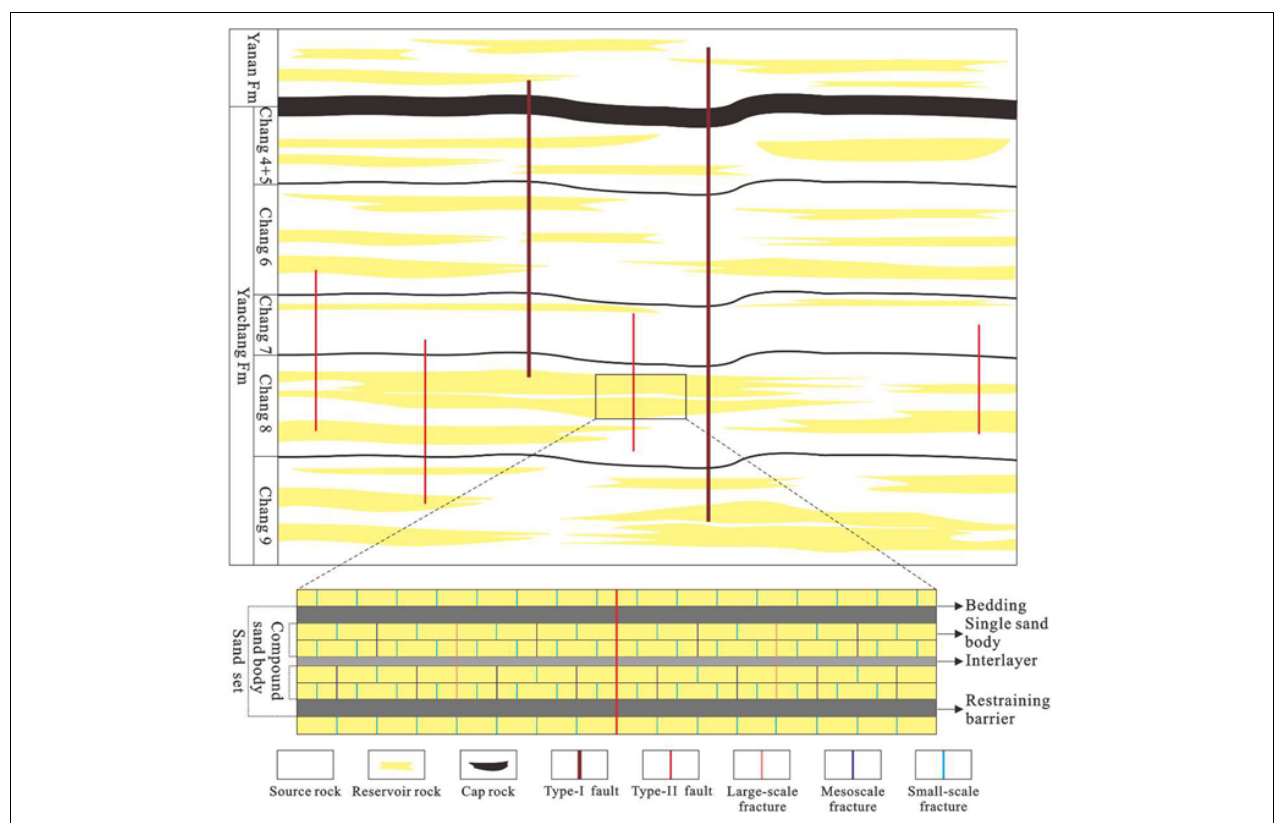
FIGURE 3 | Schematic diagram of different scale fault and fracture distribution